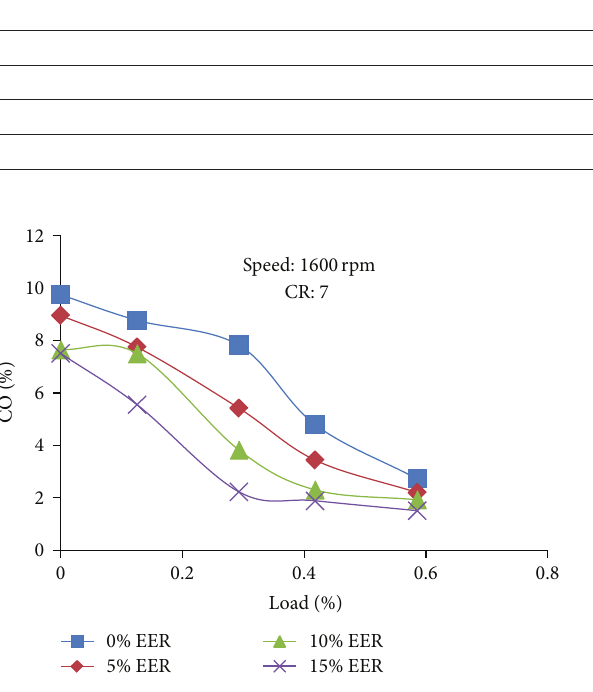
Figure 3: Effect of load on CO concentration.